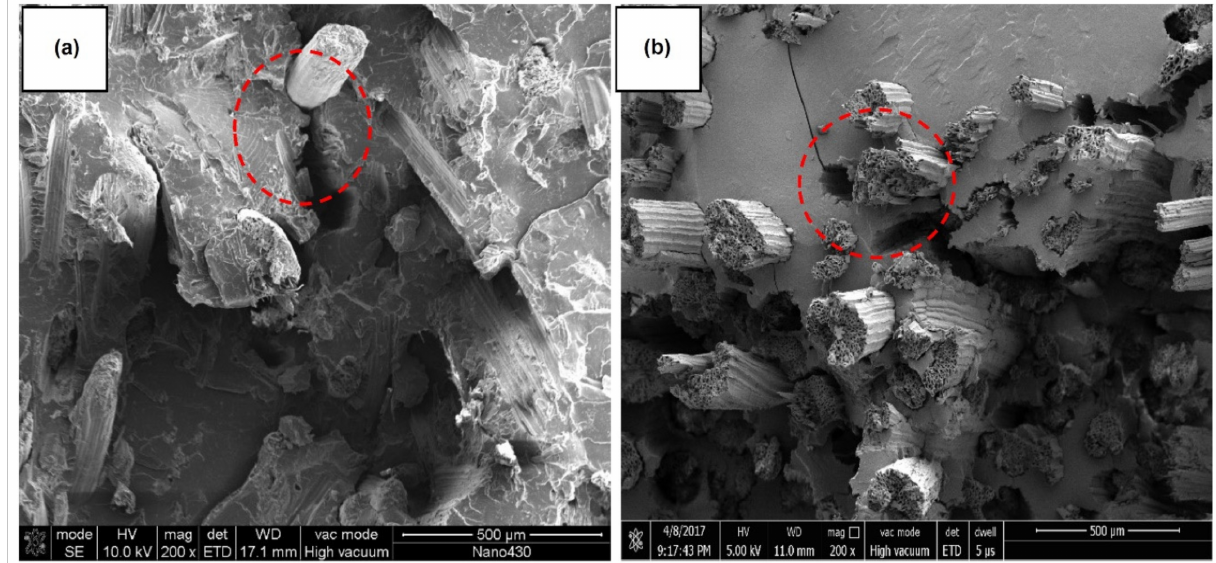
Figure 12. SEM images of ( a ) short sisal fiber-reinforced composites and ( b ) long sisal fiber-reinforced composites. Reprinted with permission from Ref. [125]. Copyright 2021, with permission from